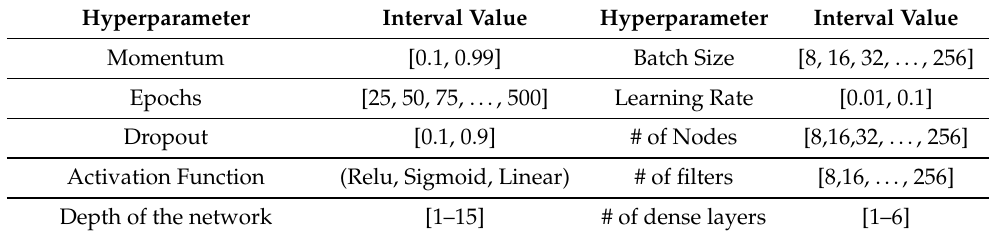
Table 2. Hyperparameters range of CNN